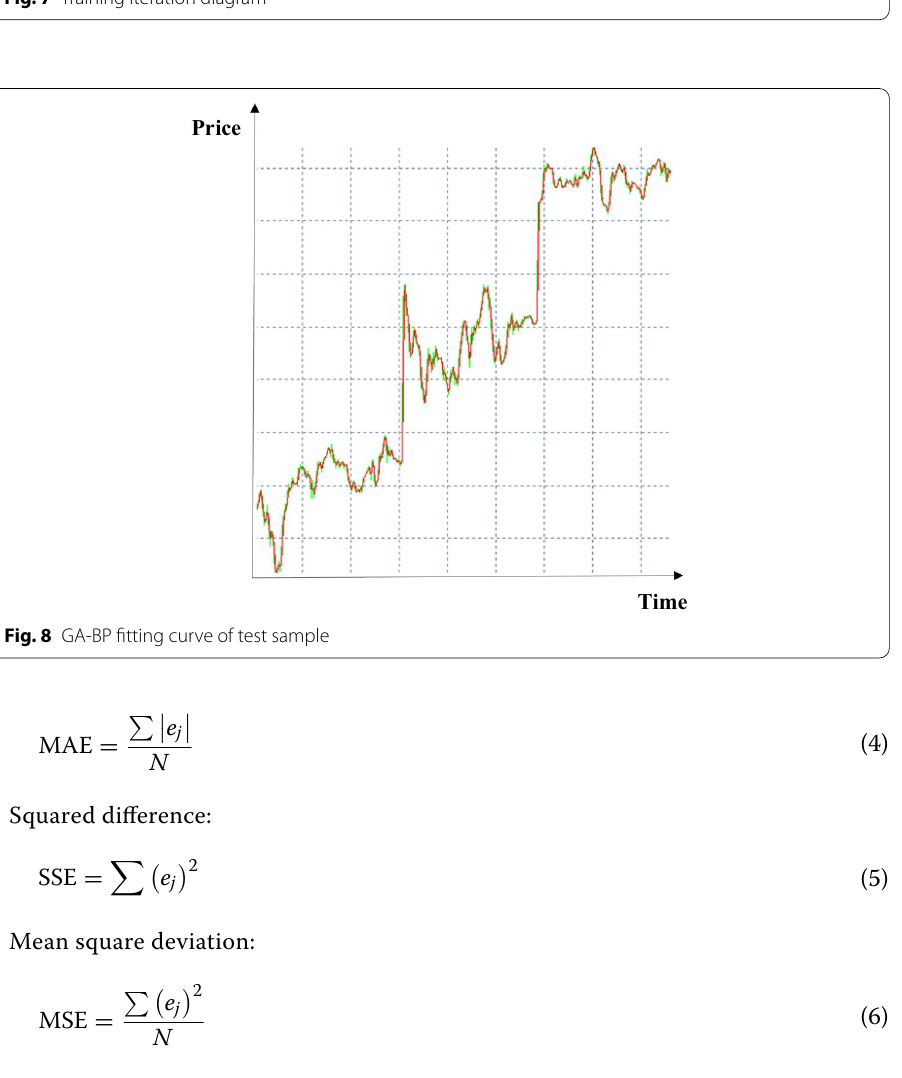
Fig. 7 Training iteration diagram